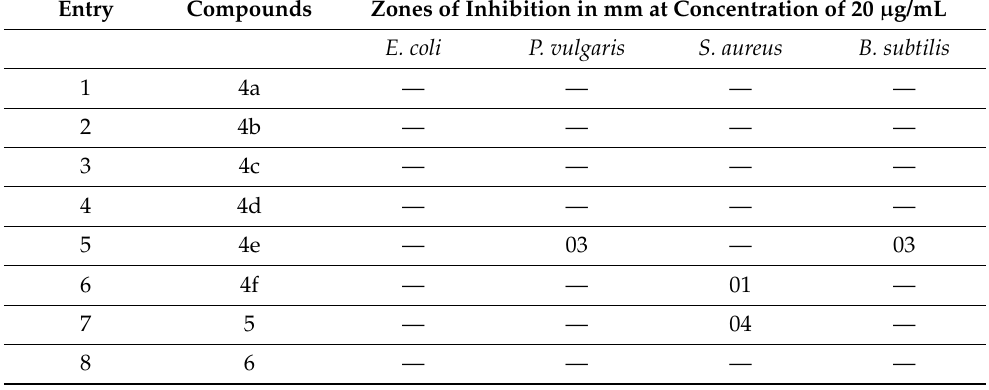
Table 4. Antibacterial activity data of 3,4-dihydropyrimidin-2-( 1H )–one. Entry